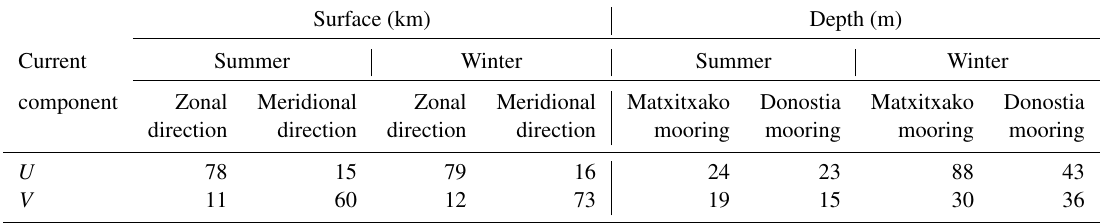
Table 2. Seasonal spatial correlation length scales for the emulated current velocity components U and V in the study area, for the summer and winter periods and in zonal and meridional directions. Note that the surface horizontal scales are shown in kilometres and that the vertical scales in depth at Matxitxako and Donostia mooring points are shown in